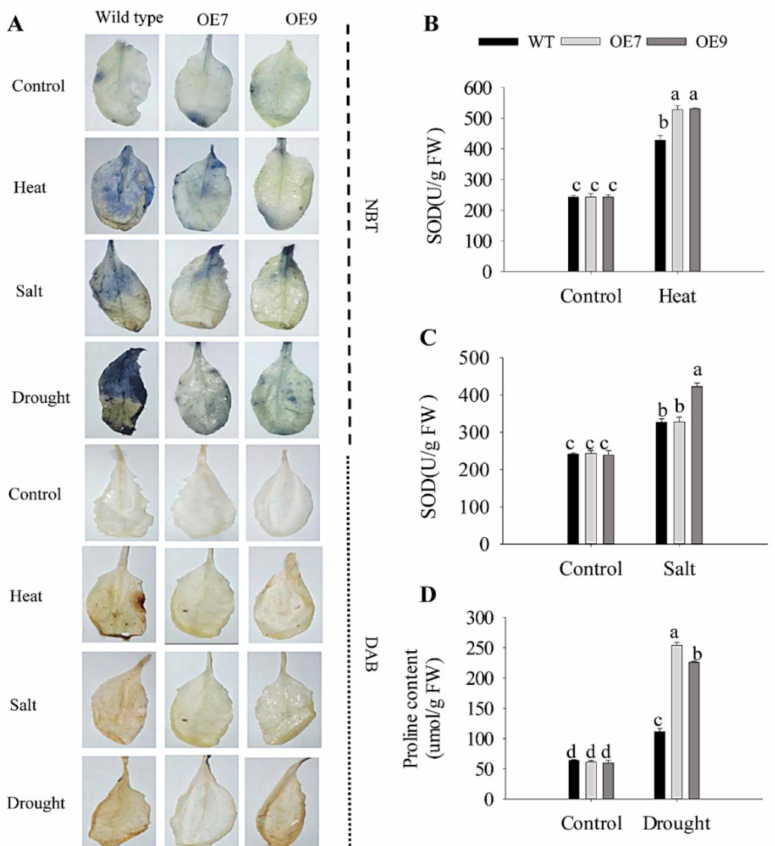
Figure 13. Study on the scavenging characteristics of reactive oxygen species (ROS) of wild-type and transgenic plants. ( A ) NBT and DAB staining of WT and transgenic plants after different stress treatments. ( B ) SOD activity of WT and transgenic lines under heat stress. ( C ) SOD activity of WT and transgenic plants under salt stress. ( D ) Proline content of WT and transgenic lines under drought stress. NBT and DAB staining showed accumulation of · O 2 − and H 2 O 2 , respectively. The error bars show the SD of three biological replicates, and values shown with different lowercase letters were significantly different at a p ≤ 0.05 level of significance. Different letters denote statistical significance ( p <